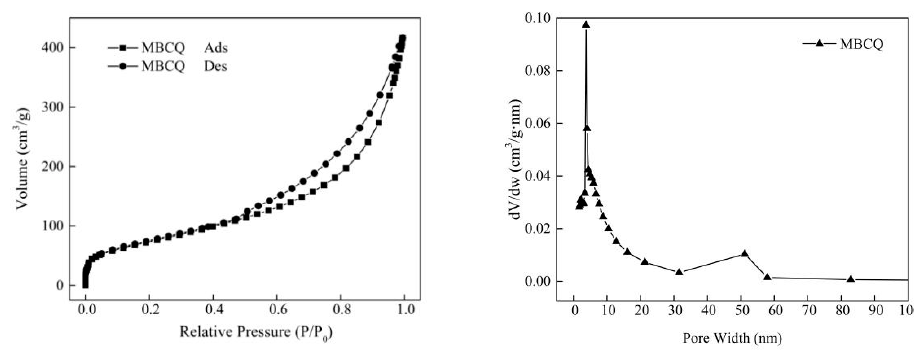
Figure 10. N 2 adsorption-desorption isotherms of MBCQ3, pore size distribution diagram of MBCQ. Table 7. BET specific surface area and pore characteristics of MBCQ.